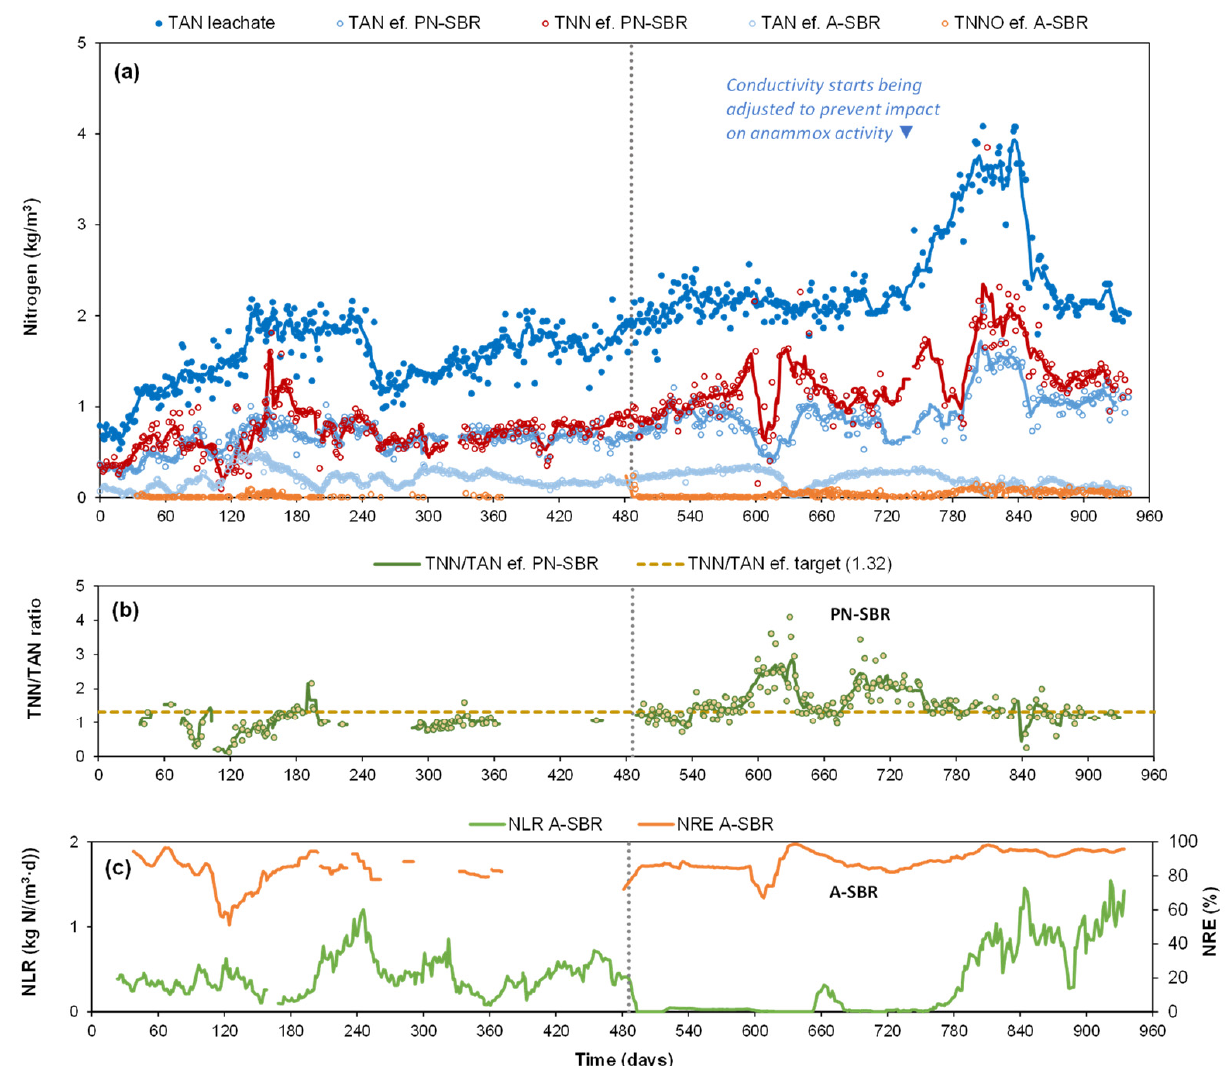
Figure 6. Performance of the full-scale system at the long-term; ( a ) Evolution of the concentration of the N species in both reactors (TAN: total ammonium N, TNN: total nitrite N, TNNO: TNN+ nitrate N); ( b ) TNN/TAN ratio in the PN-SBR effluent; ( c ) N loading rate and removal efficiency in A-SBR. Day 0 is 1 September 2017. The vertical dashed lines indicate when the landfill site stop receiving solid waste (on day 486). Table 2. Summary of the operational conditions applied in PN-SBR and A-SBR at the long-term. Parameter Average ± SD PN-SBR IFR (m 3 /d)